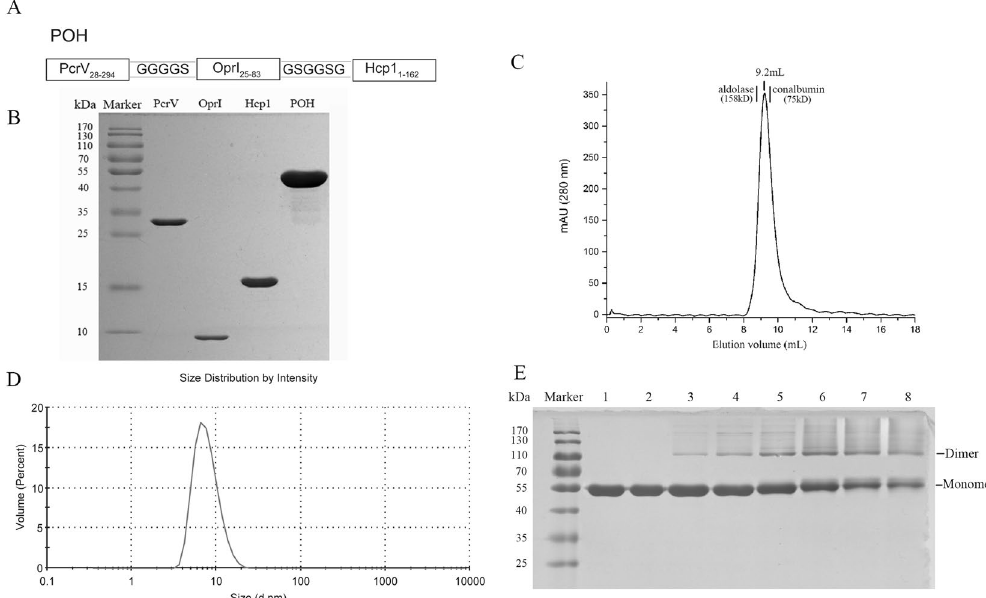
Figure 1. Preparation and characterization of antigens. ( A ) Schematic diagram illustrating the primary structure of POH. ( B ) PcrV, OprI, Hcp1 and POH were purified and analyzed by SDS-PAGE. ( C ) Oligomeric states of POH determined by size elution chromatography. The elution volumes for POH, protein standard aldolase (158 kDa) and conalbumin (75 kDa) were 9.2 ml, 8.8 ml and 9.6 ml, respectively. ( D ) Dynamic light scattering analysis of POH demonstrated that POH formed a symmetrical peak with a diameter of 6.9 nm, and the estimated molecular weight was approximately 91.2 ± 22.4 kDa. ( E ) SDS-PAGE analysis of POH after treatment with different concentrations of glutaraldehyde. Lane 1 shows the native POH. Lanes 2 to 8 show the formation of dimers or aggregates with the increasing concentration of glutaraldehyde (0.01%, 0.05%, 0.1%, 0.2%, 0.3%, 0.4%, and